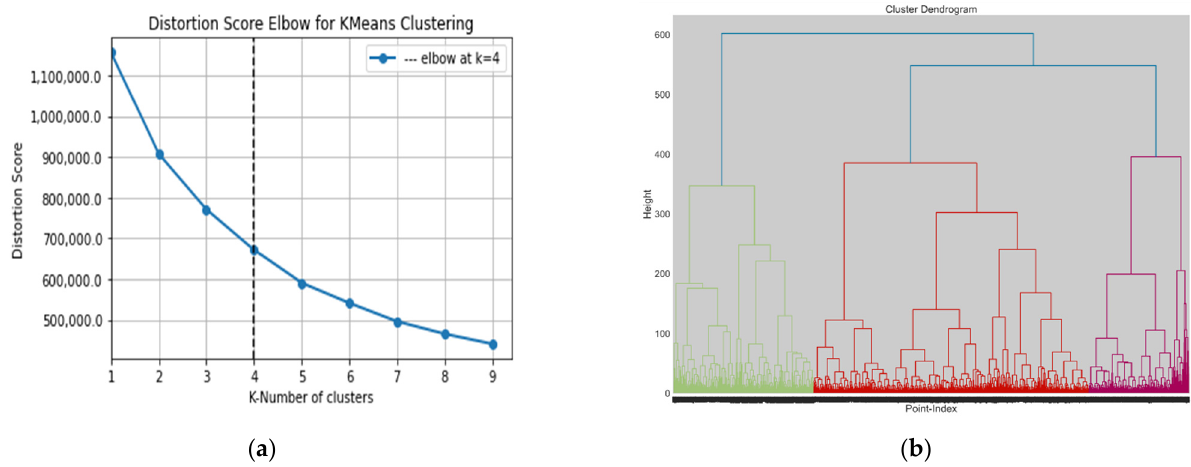
Figure 5. The optimal number of clusters for the second investigation object: the elbow method ( a ) shows that the optimal number of clusters is equal to 4, while on the dendrogram ( b ), the possibility of the optimal number of clusters is also equal to 3.